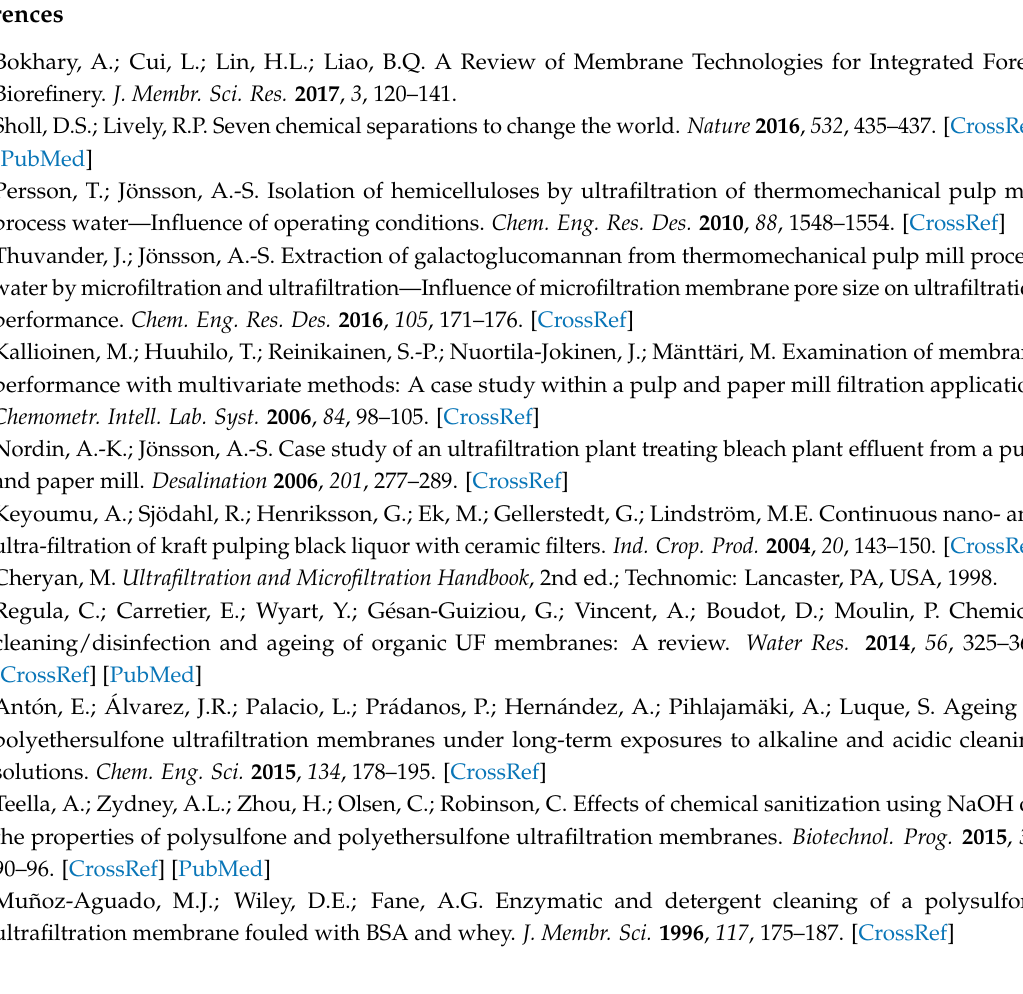
Figure S1: Normalized membrane permeability after fouling with TMP process water as well as after treatment with each cleaning agent. The water contact angles of the cleaned membrane samples are shown above the figure. The contact angle of the conditioned membrane was 71.5 ◦ . New membrane samples were used in all